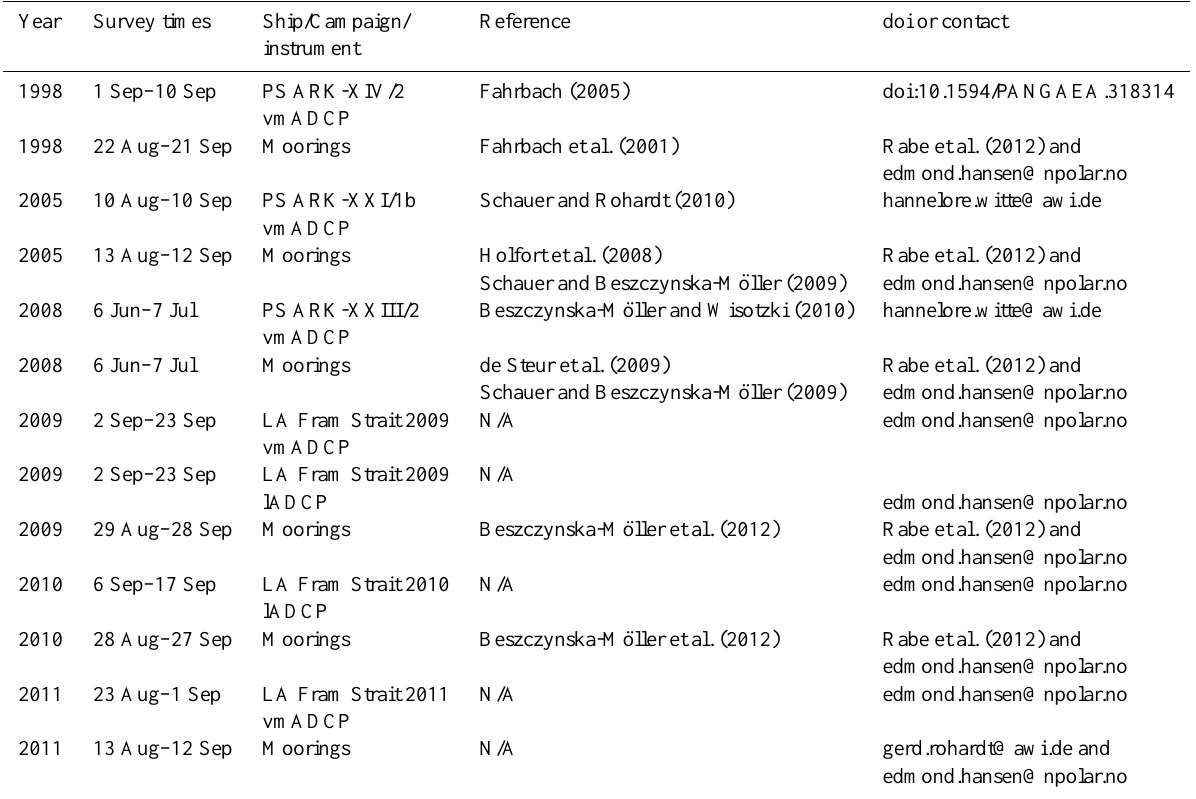
Table 3. Data sources by year and campaign, showing references to available velocity observations from the ship and from moorings, where available. Entries with a cruise label refer to ship-based observations, others refer to moored observations. At least one of the following references are given: a full citation of the database entry in the PANGAEA database; the publication, where data were first shown; the contact e-mail of the PI. Only the part of the velocity data from moorings in the central and Eastern Fram Strait up to 2010 are in the PANGAEA database. E-mail contacts are given for the moorings in 2011 and for all years in the Western Fram Strait. Ship abbreviations are the same as in Table 2. The mooring data were averaged over a time period of about one month, with the corresponding dates given under “survey times”. These time periods are centred around the survey times given in Table